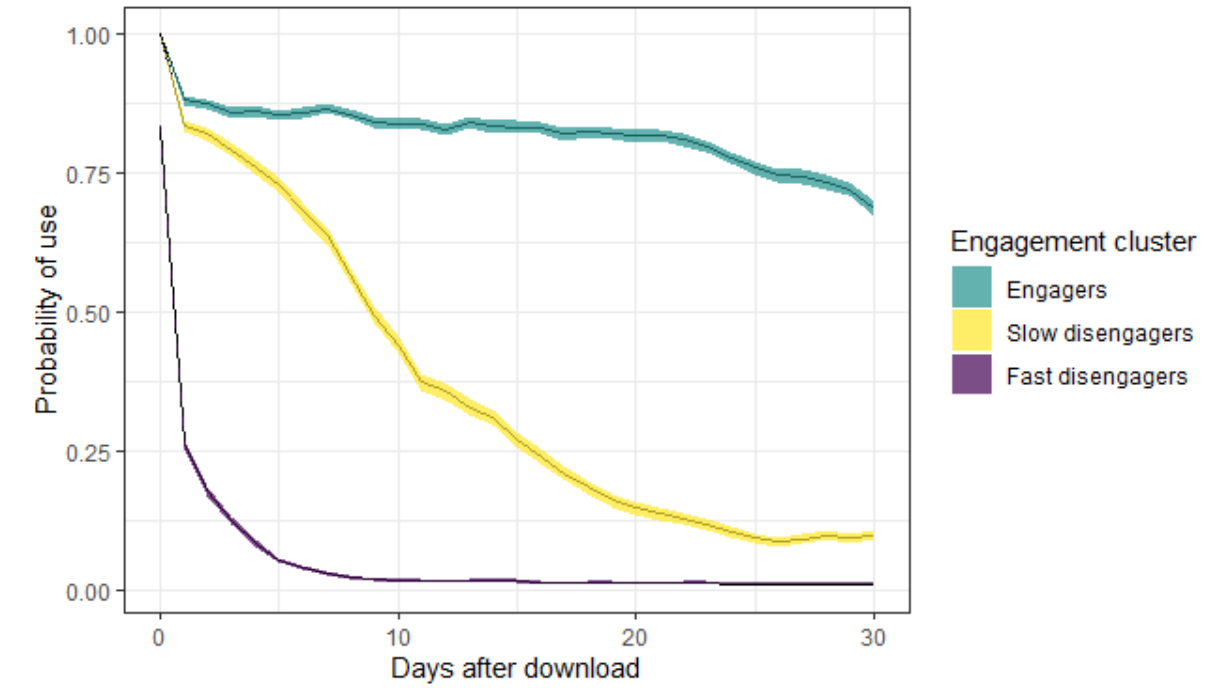
Figure 4. Probability of use on day after download by cluster group with 95% CIs.